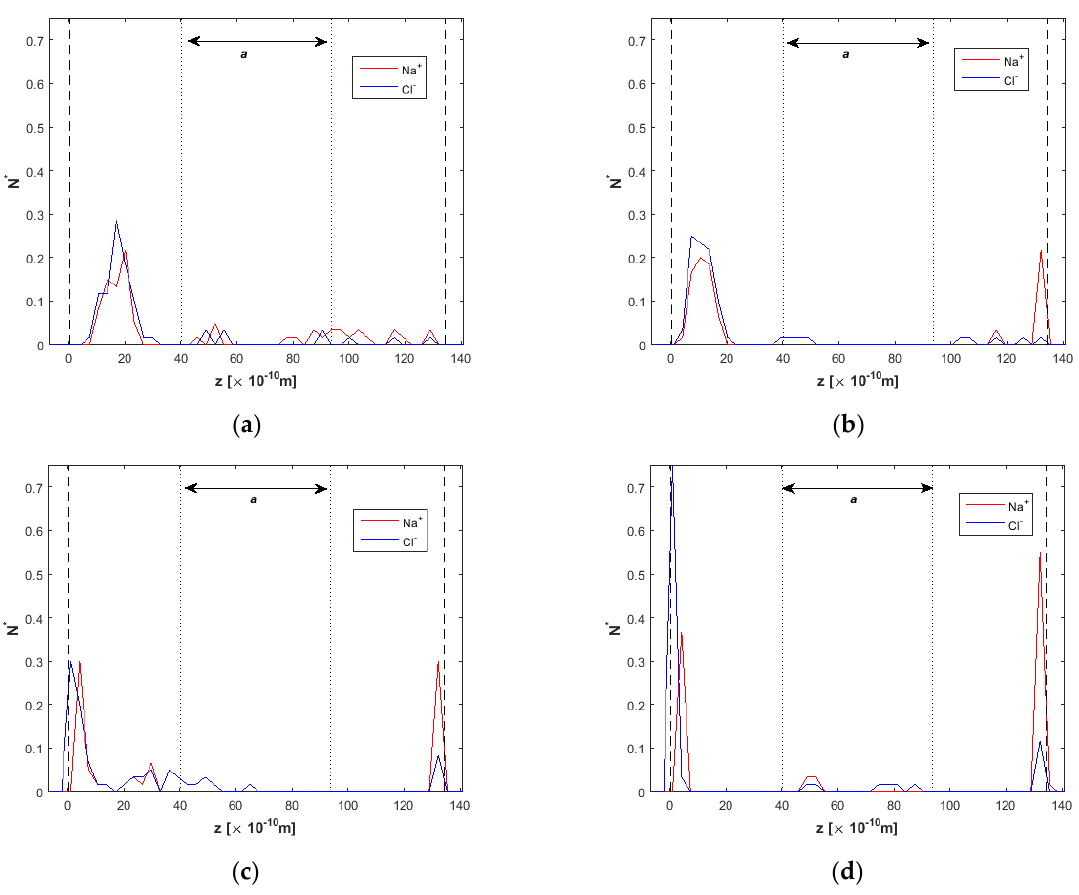
Figure 10. Ion concentration across the h = 13.5 nm nanochannel for various values of the external electric field at simulation time t = 15 ns, F ext = 0.025 kcal / molÅ, ( a ) E = 0.1 V / Å, ( b ) E = 1.0 V / Å, ( c ) E = 2.0 V / Å and ( d ) E = 3.0 V / Å. Dashed lines denote wall limits and dotted lines enclose the desired clean water region.